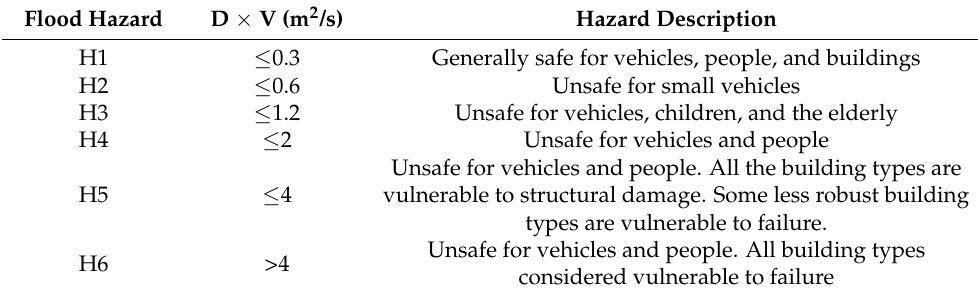
Table 1. Hazard classification based on flood depth and flood velocity according to the AIDR [87]. Flood Hazard